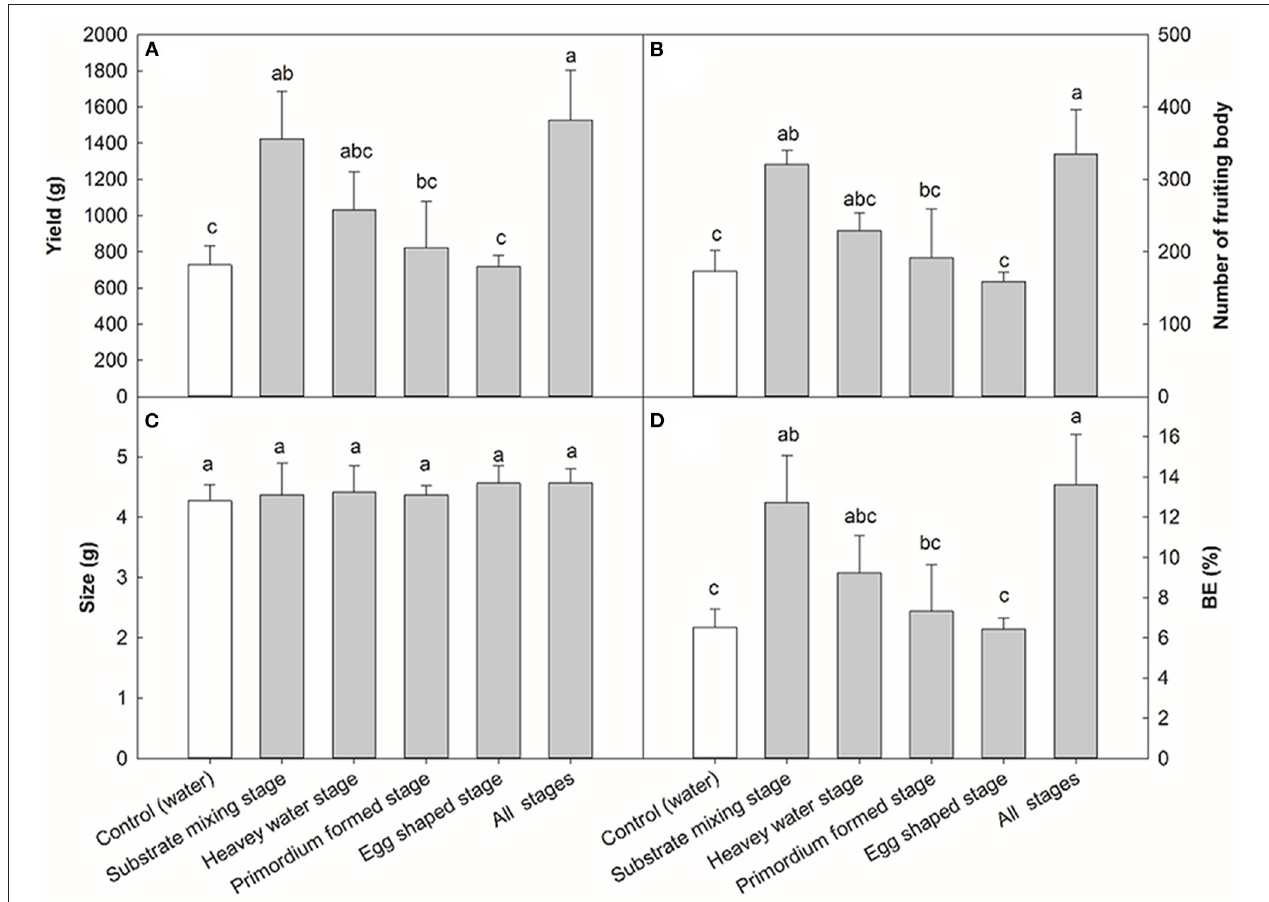
FIGURE 2 | Effects of NaAc sprayed at different stages on V. volvacea yield (A) , number of fruit bodies (B) , size (C) and biological efficiency, or BE (D) . Bars indicate the mean ± SD, n = 5 at each stage, while different letters indicate treatments that differed significantly by one-way ANOVA. Note: heavy stage: 5 days after inoculation the spawn; primordium formation stage: 7 days after inoculation of the spawn; egg stage: 9 days after inoculation of the spawn; all stages: mixed substage stage + heavy stage + primordium formation stage + egg stage.